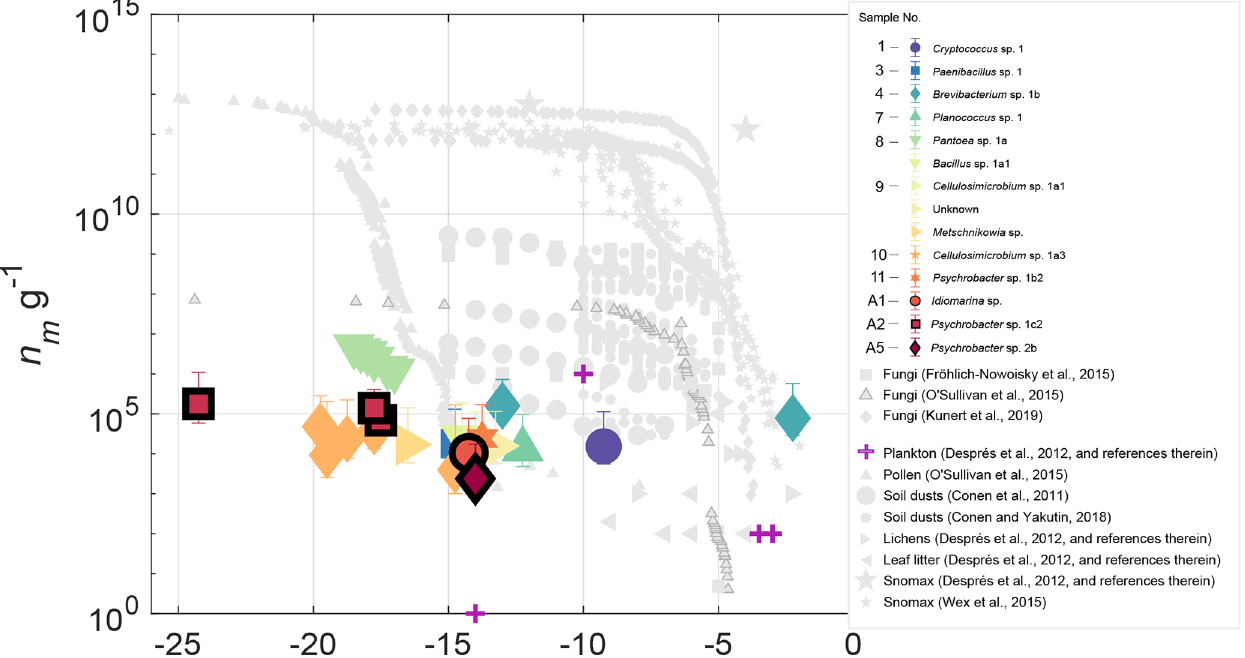
Figure 4. INP concentrations (g − 1 biomass) for 14 halotolerant isolates derived from precipitation and aerosol samples. Also shown are INP observations of various biological particles from published studies. The sample numbers in the legend indicate the precipitation or aerosol sample from which the isolate was derived (see Table S3). Data points corresponding to isolates from aerosol are outlined in black. Error bars indicate the 95% confidence intervals and uncertainty associated with the biomass estimate (see Sect. 3.3 for details). Only freezing activity that was significantly enhanced ( p< 0 . 005) above ZoBell growth media is shown. Results show that with the exception of Brevibacterium sp., isolates are generally less efficient ice nucleators than most biological INPs of terrestrial